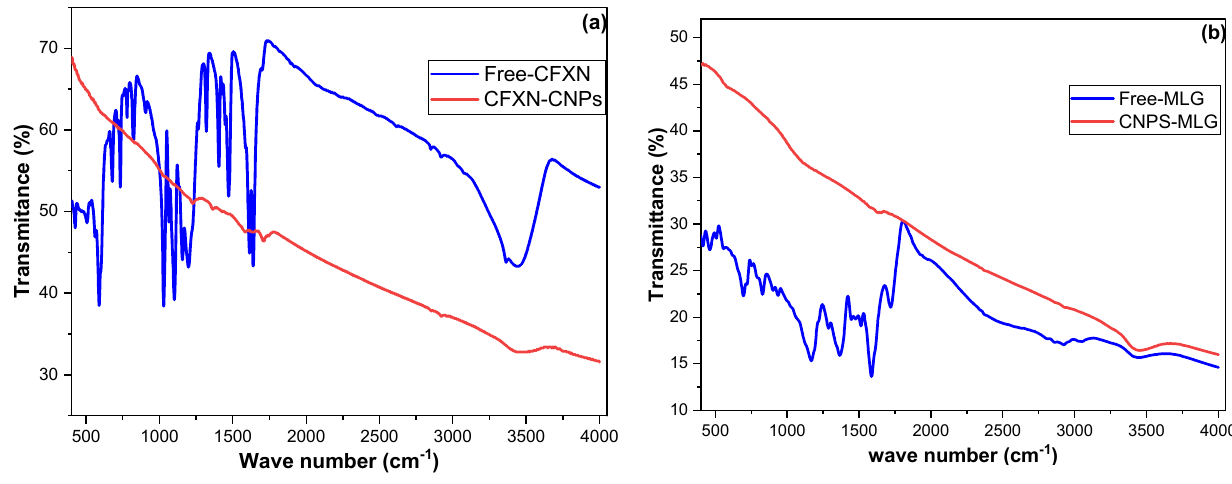
Figure 8. FTIR spectra of ( a ) free CFXN molecules and as adsorbed onto CNPs; ( b ) free MLG molecules and as adsorbed onto CNPs.